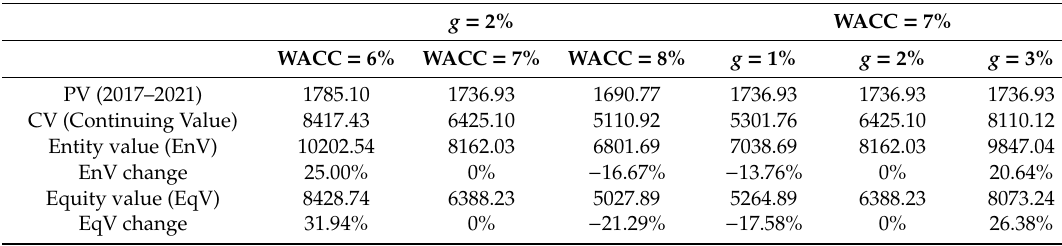
Table 2. Sensitivity analysis (in million GBP).